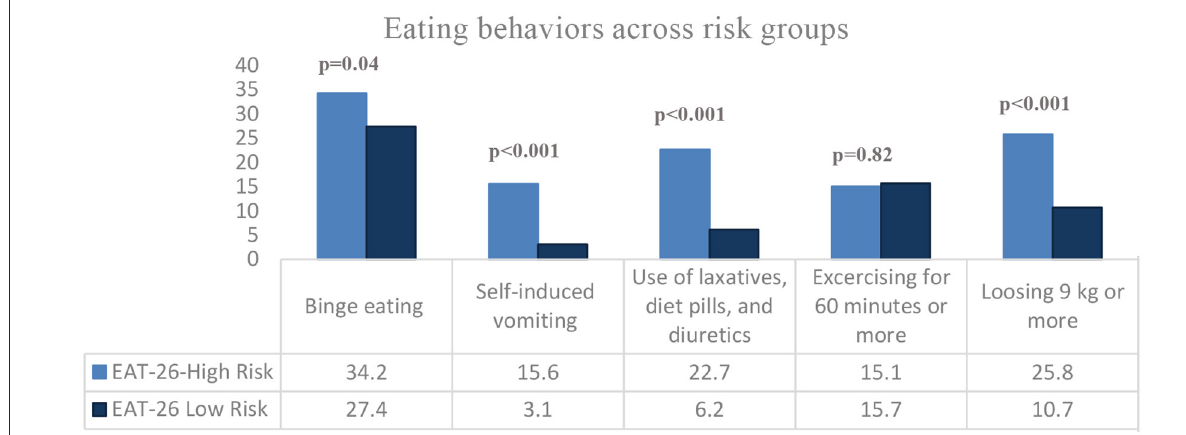
FIGURE3 Disordered eating behaviors in study